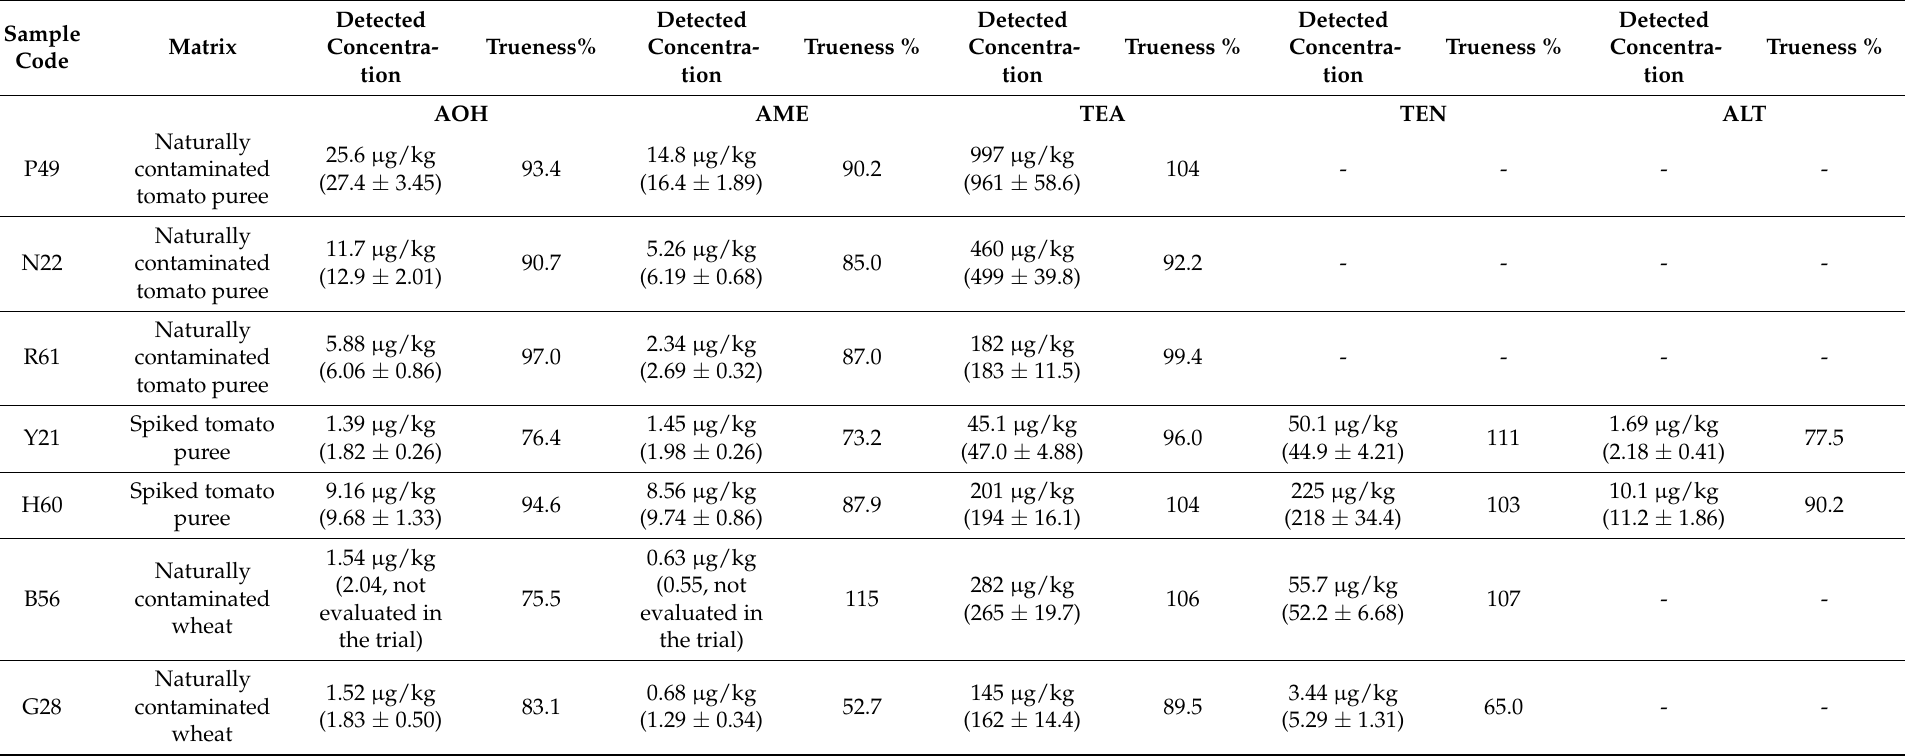
Table 2. Results of the quality check (QC) sample analysis using the dilute and shoot method. The reference values and corresponding standard deviations, obtained from the method validation trial, are in brackets below the detected